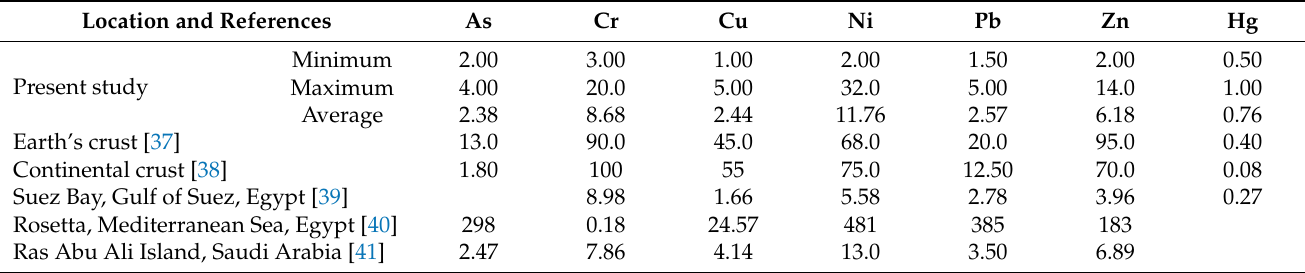
Table 2. Minimum, maximum and average values of PTEs (mg/kg, dry weight) in the study area, along with those from background references and other coastal